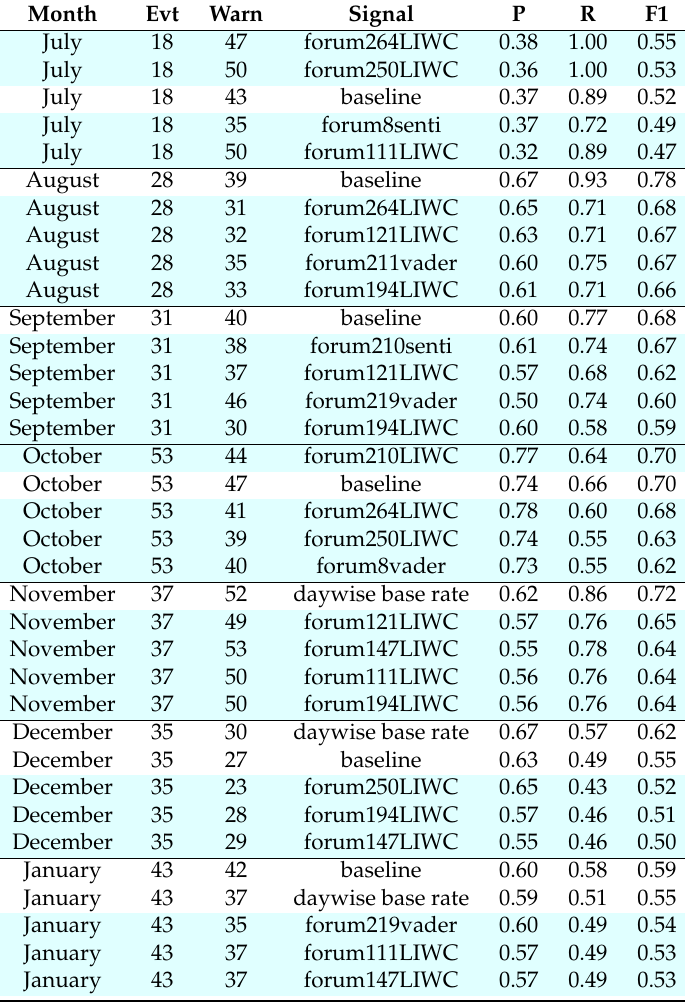
Table A4. Results from Organization B’s endpoint